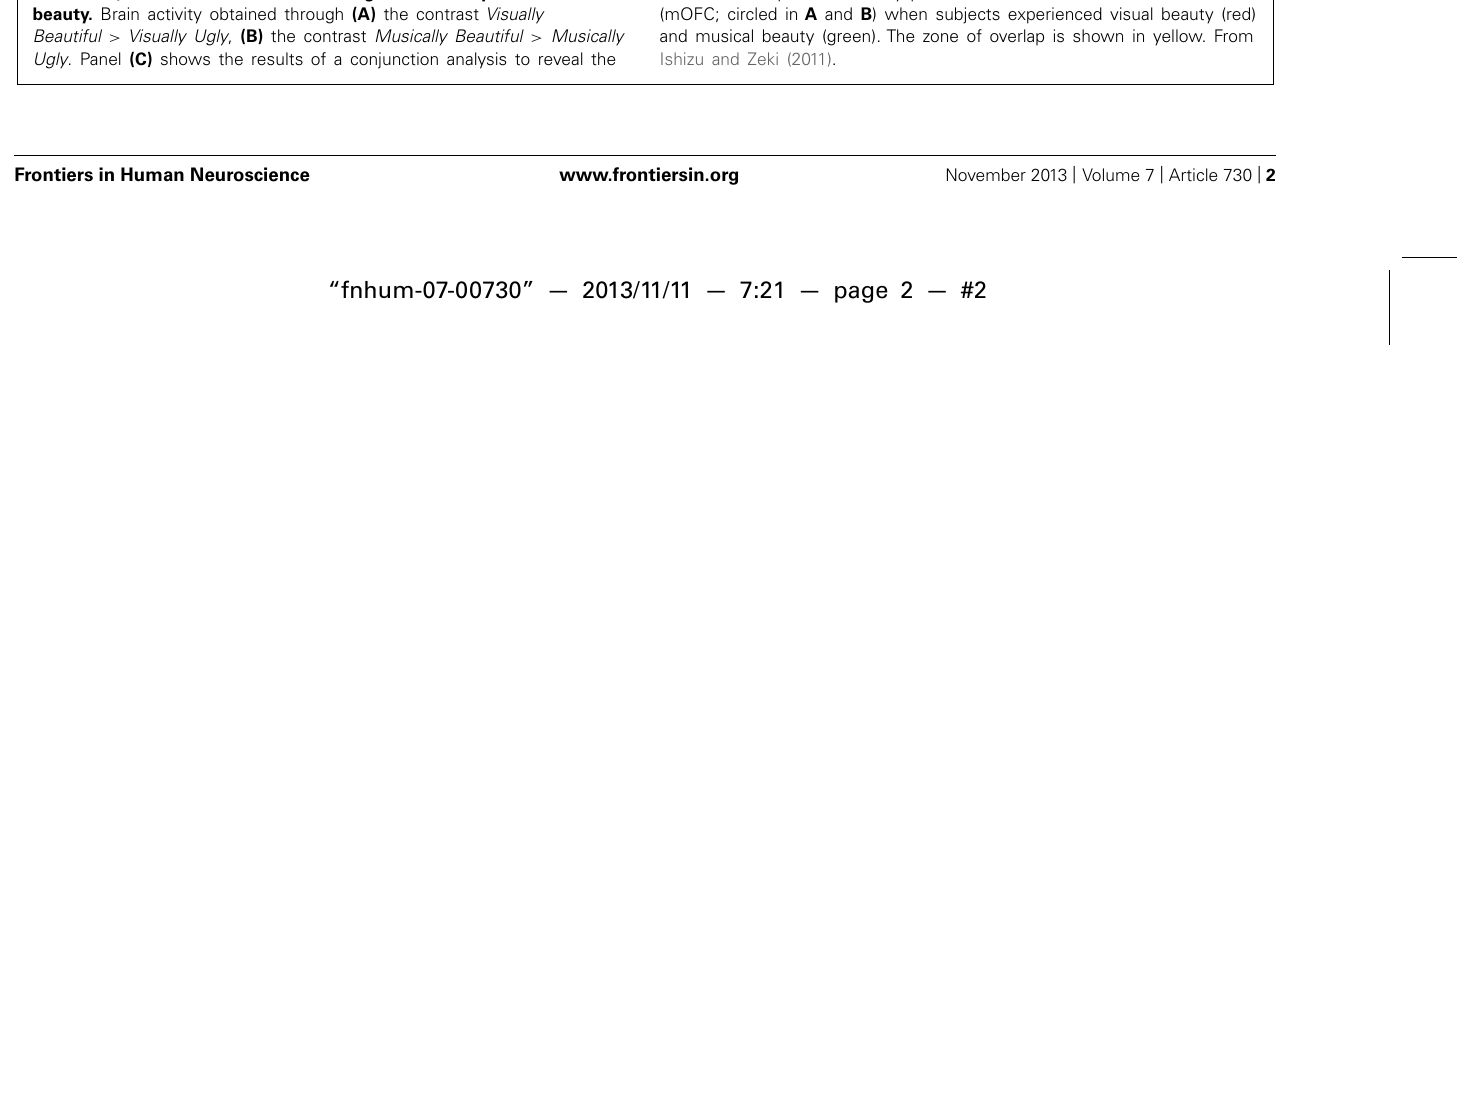
areas of overlap in the activity produced in the medial orbito-frontal cortex (mOFC; circled in A and B ) when subjects experienced visual beauty (red) and musical beauty (green). The zone of overlap is shown in yellow. From Ishizu and Zeki